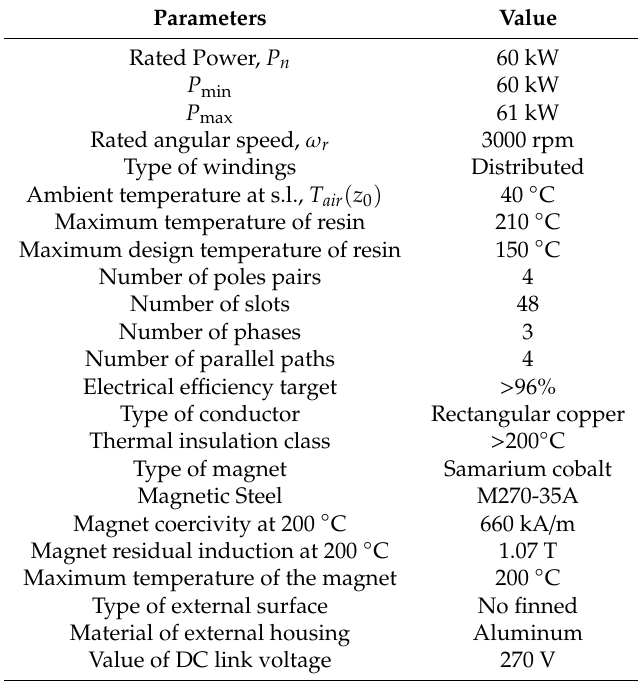
Table 1. Desired motor characteristics Problem 1.